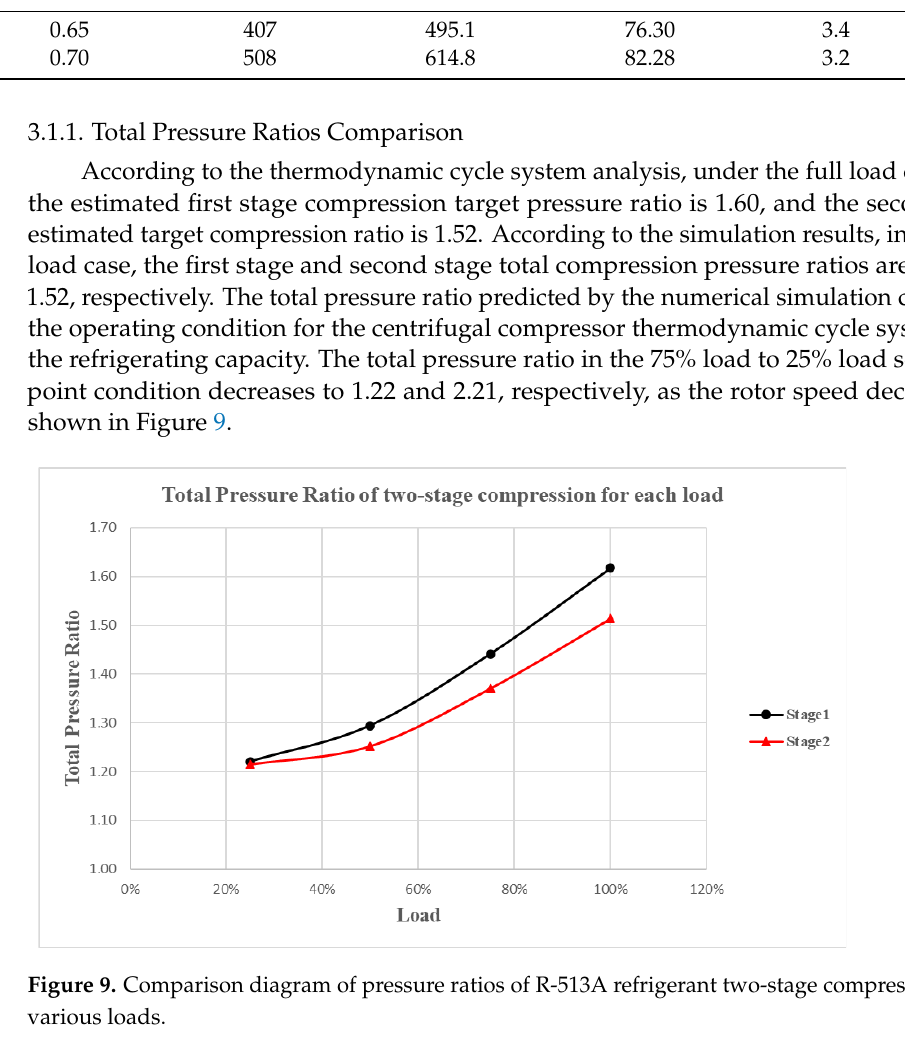
Table 9. Numerical simulation results for R-513A refrigerant two-stage centrifugal compressor loads.